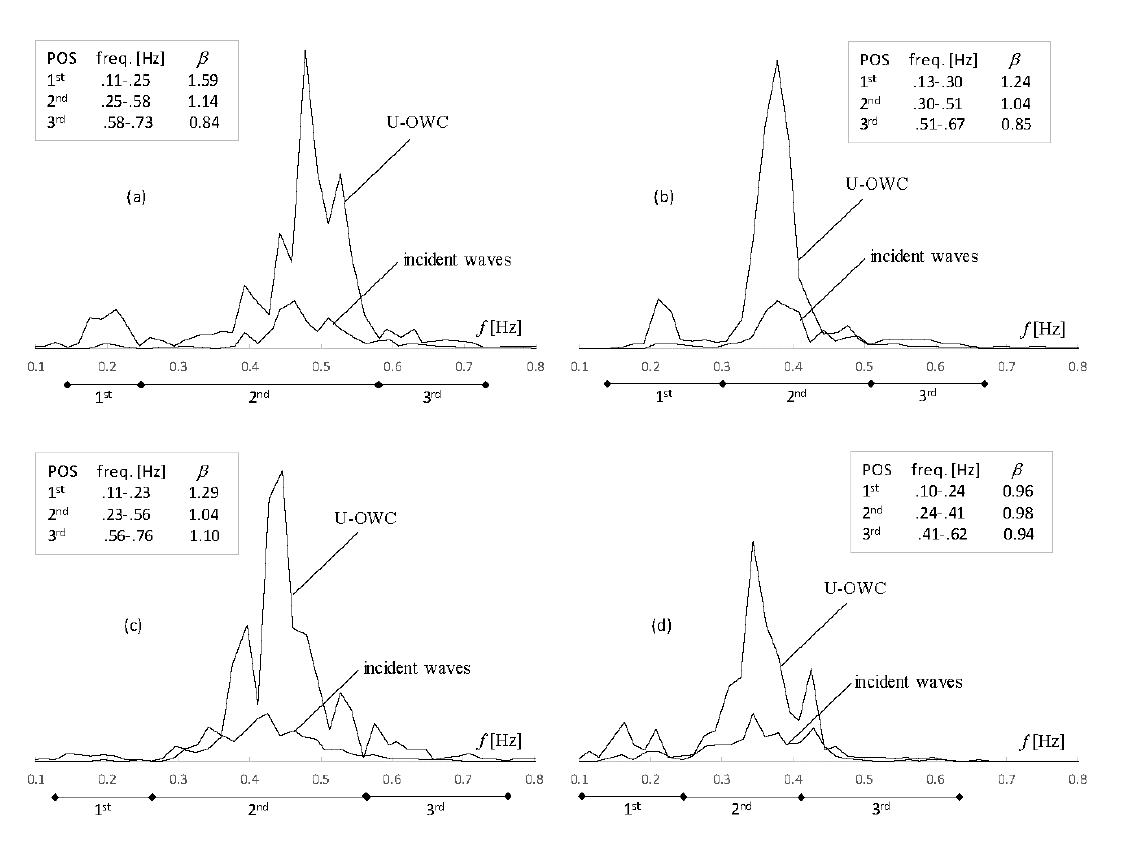
Figure 7. Frequency spectra of the pressure fluctuations recorded at the upper opening of the vertical duct and in the undisturbed wave field. For each sea state some values of the amplification factor β of piece of spectrum are reported. In Registration ( a ), 25% of absorption of the whole incident energy has been measured; 81% in Registration ( b ); 42% in Registration ( c ); and 52% in Registration ( d